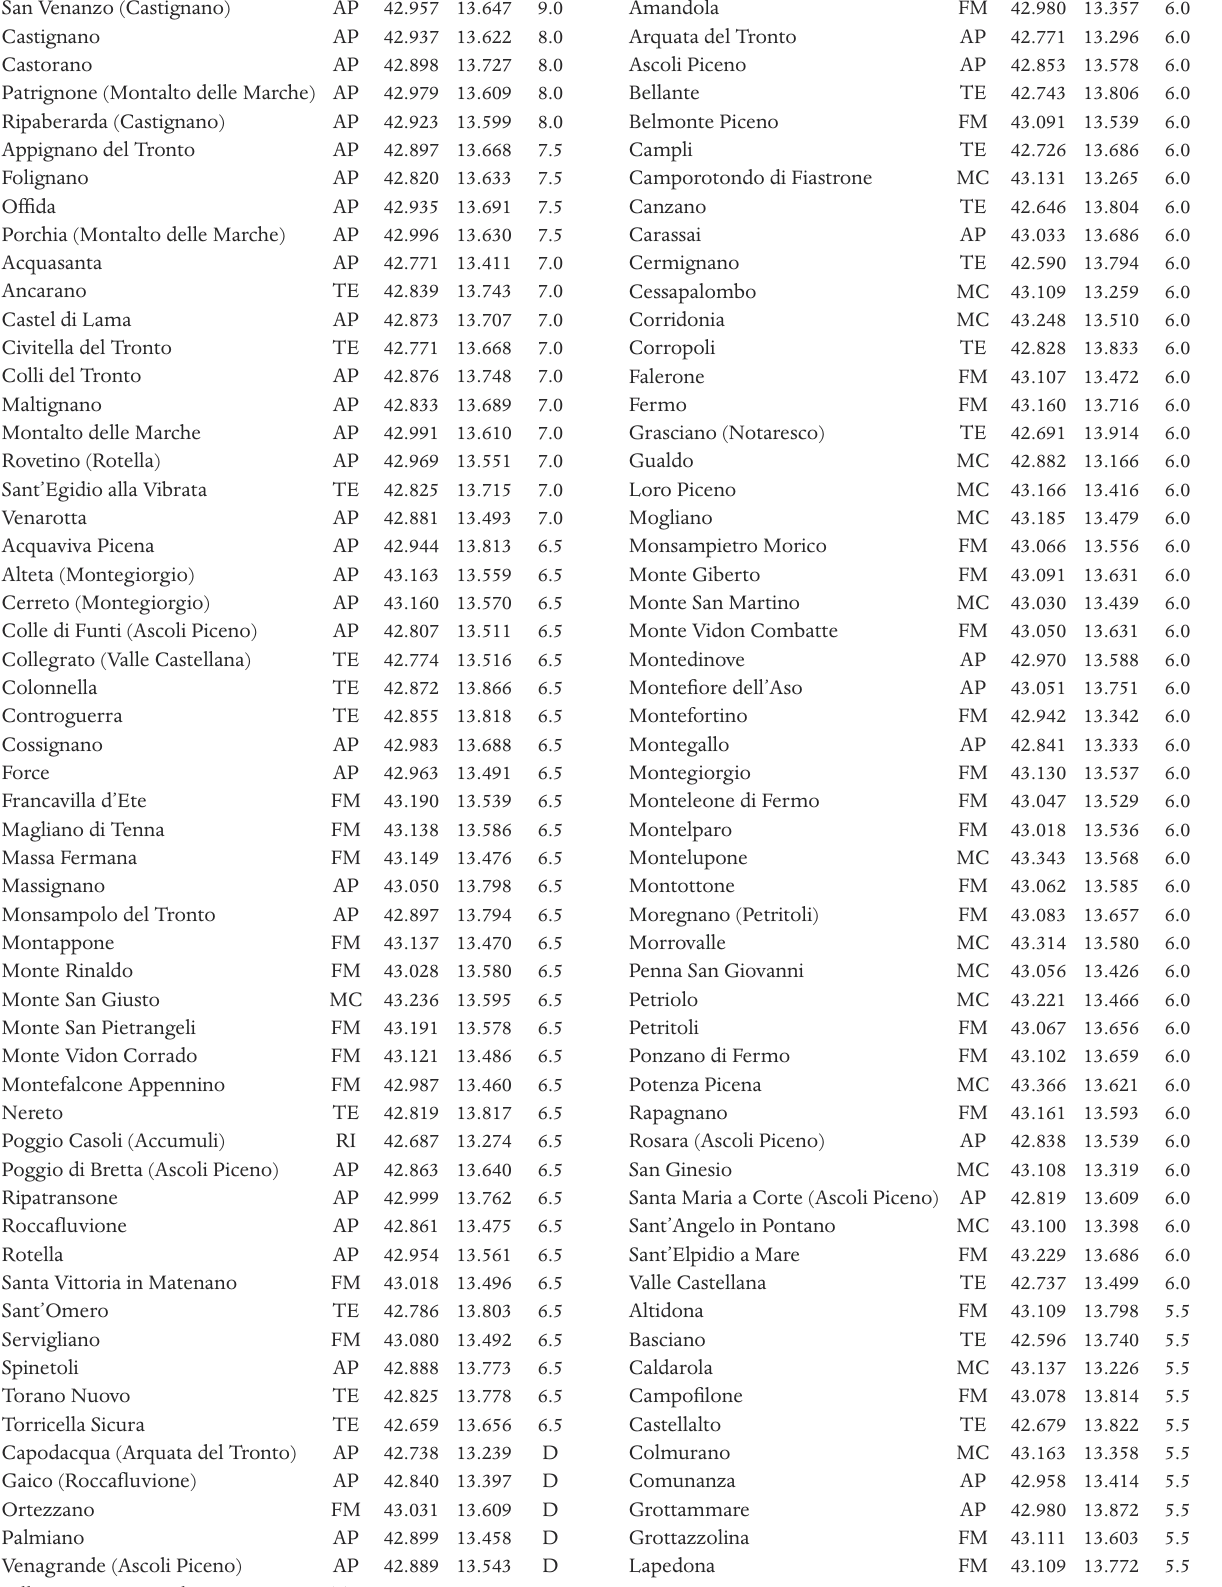
Table 1 (columns from left to right). List of intensity points after the reappraisal. pr: province (presently effective); D (Damage) indicates a single building damage without anyother information related to that locality; F (Felt) indicates a generic perception of the